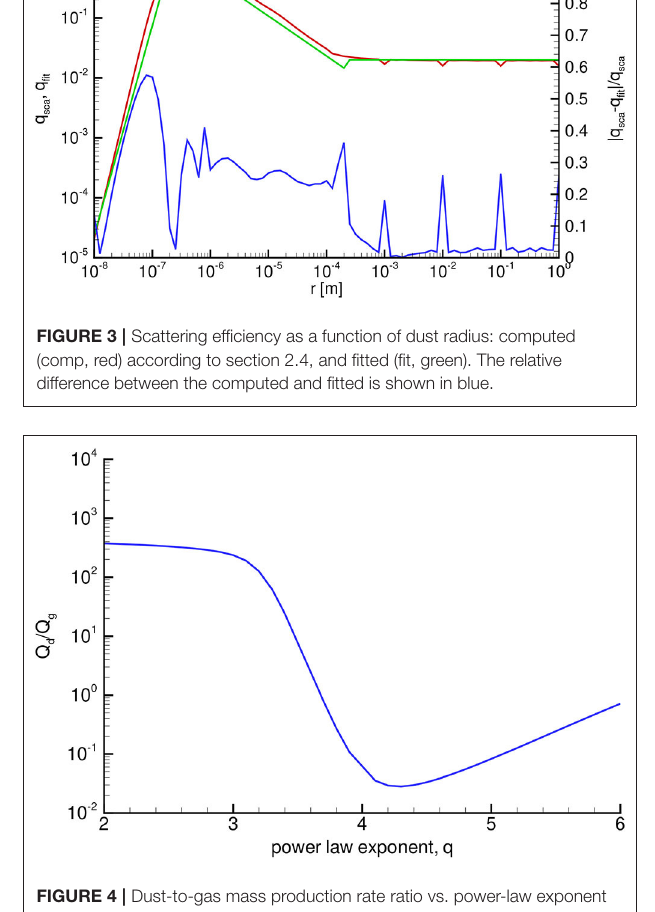
the dust size distribution for the same brightness. With